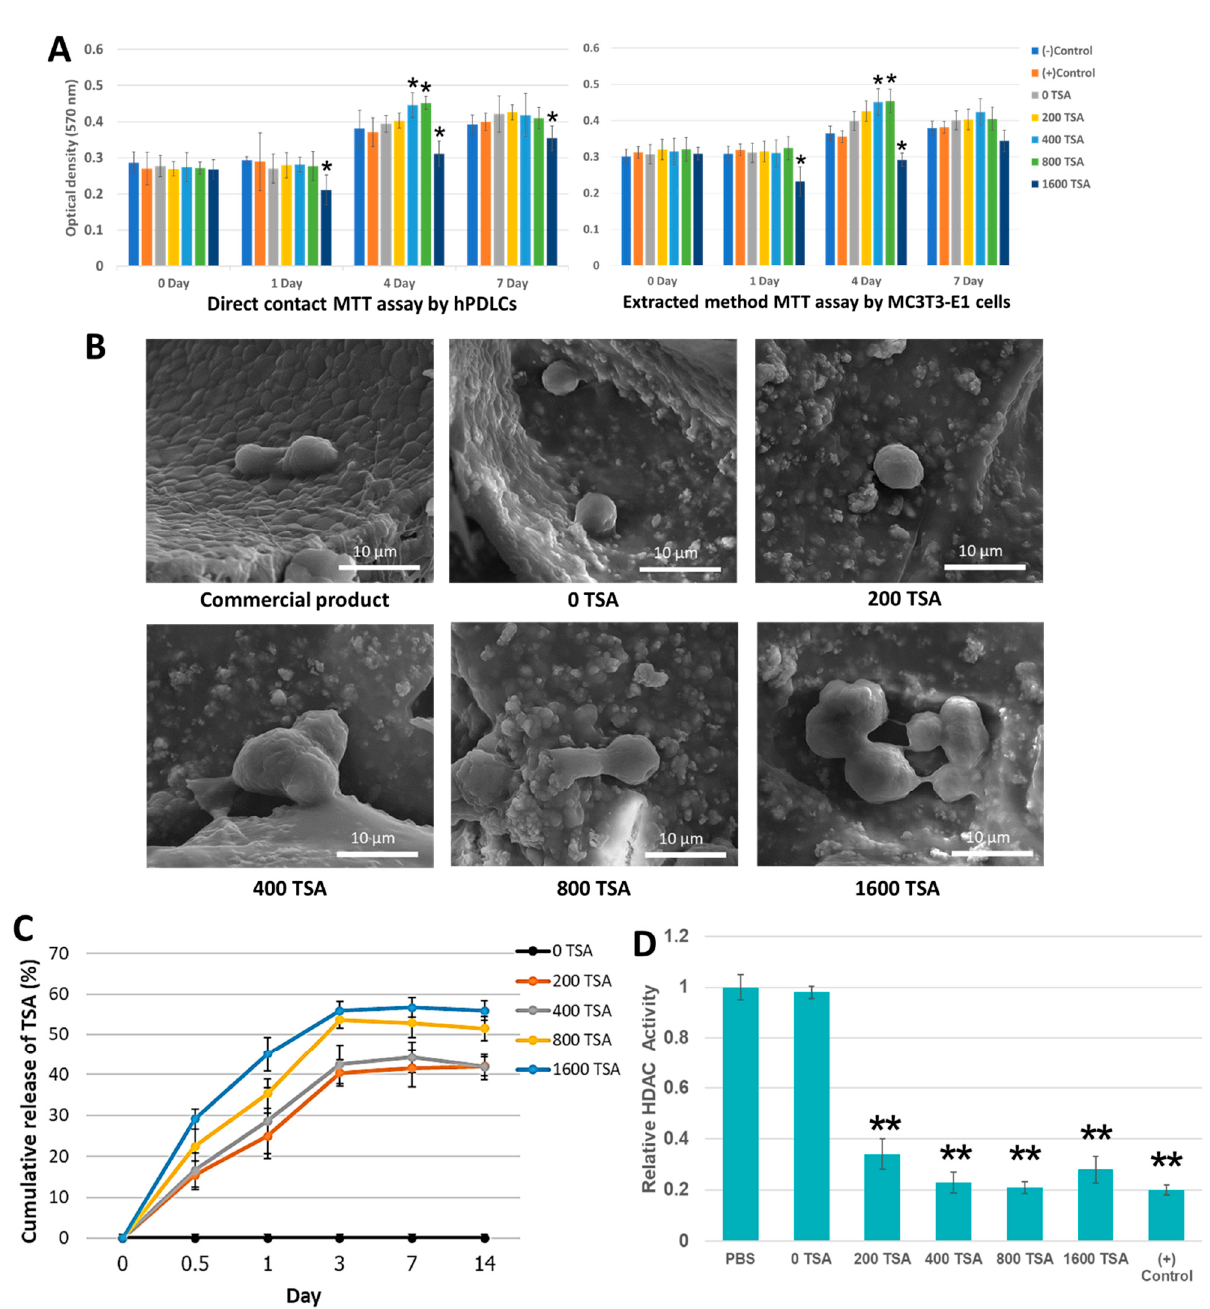
Figure 4. Biological properties of CS/BCP/TSA scaffolds in various TSA concentrations. ( A ) Cyto- compatibility of CS/BCP/TSA scaffolds in various TSA concentrations by direct contact method with MTT assay. ( B ) SEM microphotographs of the hPDLCs cultured on CS/BCP/TSA scaffolds in various TSA concentrations. ( C ) Cumulative release curve of TSA. ( D ) The HDAC activity of hPDLCs treated with conditioned media of CS/BCP/TSA scaffolds. Values are defined as mean ± SD. * p < 0 . 05; ** p < 0 . 01 .